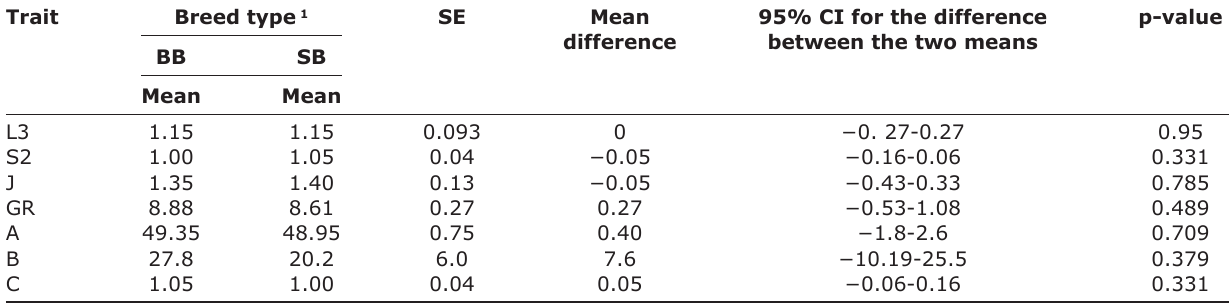
Table-3: Means, SE, and 95% CI for the difference between the means for fat thickness and M. longissimus measurements of BB and SB kids. Trait